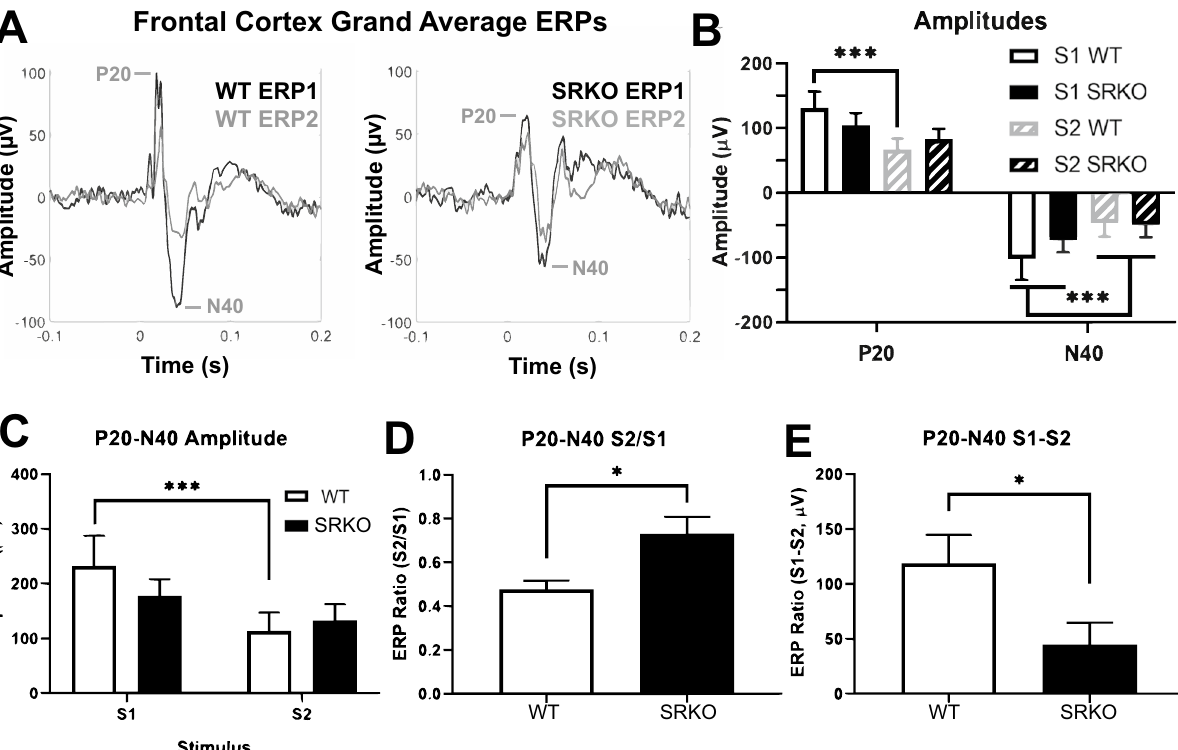
Figure 3. Sensory Gating is Impaired in SRKO mice. Sensory gating was measured in the frontal cortex EEG of SRKO mice (n = 10) and WT littermates (n = 9) by averaging the evoked response potential (ERP) of 100 repetitions of two identical 5 kHz 50 ms tones (S1 and S2) separated by 500 ms. Frontal cortex grand average ERP’s are superimposed in ( A ) for WT ( left ) and SRKO ( right ) animals. Although N40 was larger in S1 than S2 for all animals, only WT animals had significantly larger P20 and P20–N40 amplitudes in S1 than in S2 ( B , C ). The P20–N40 amplitude was normalized as a ratio between ERP1 (from S1) and ERP2 (from S2) before comparing between groups. Compared to WT littermates, SRKO mice had a reduced gating response of P20–N40 amplitude in the frontal cortex as evidenced by a larger S2/S1 ratio ( D) and an attenuated difference between S1 and S2 P20–N40 amplitudes ( E ). Stars in ( B ) and ( C ) represent a main effect of stimulus in a two- way RM ANOVA (N40) or significance in a Holm–Sidak post hoc test following a significant interaction in